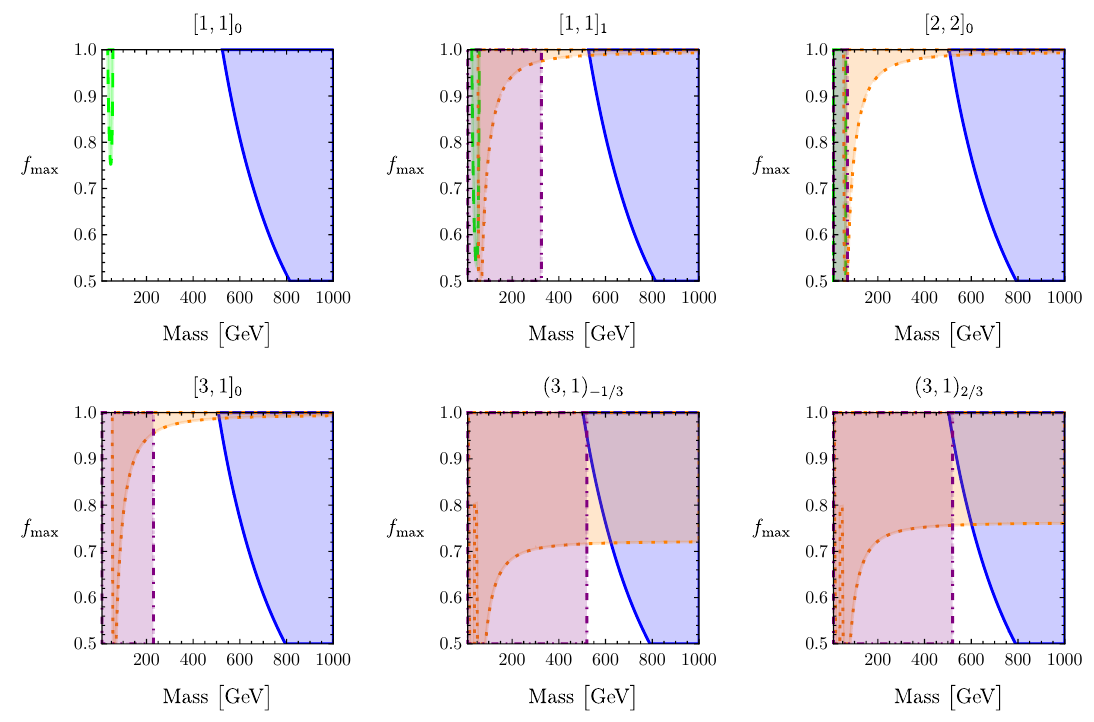
Figure 8 . Regions of parameter space for scalar Loryons which are ruled out by one of the constraints described earlier. The orange, dotted region is ruled out by constraints on κ the blue, solid region is ruled out by unitarity bounds; the green, dashed region is ruled out by constraints on Higgs decay; and the purple, dot-dashed region is ruled out by direct search bounds. All plots assume no mass splitting between the components of the Loryon multiplet, which is a non-trivial assumption for [2 , 2] . Note that the bottom middle and right plots are indicated by 0 their SM gauge quantum